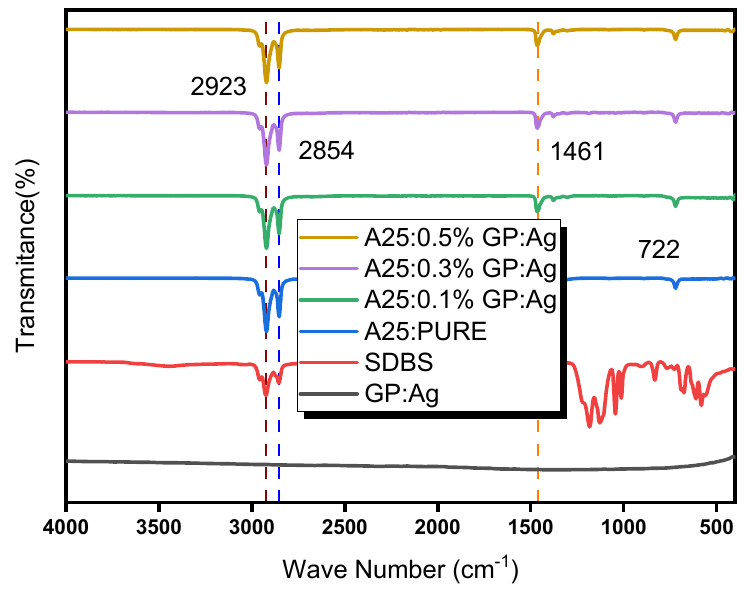
Figure 4. FTIR plot of base, nanoparticles, HNePCMs.